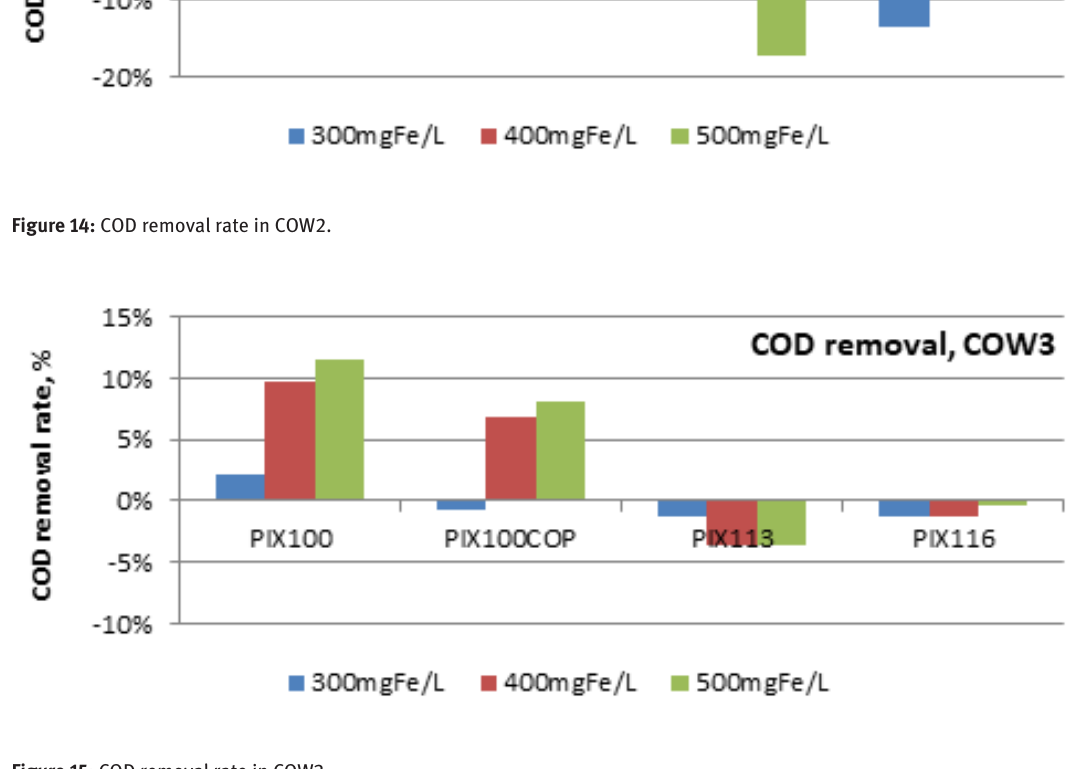
Figure 15: COD removal rate in